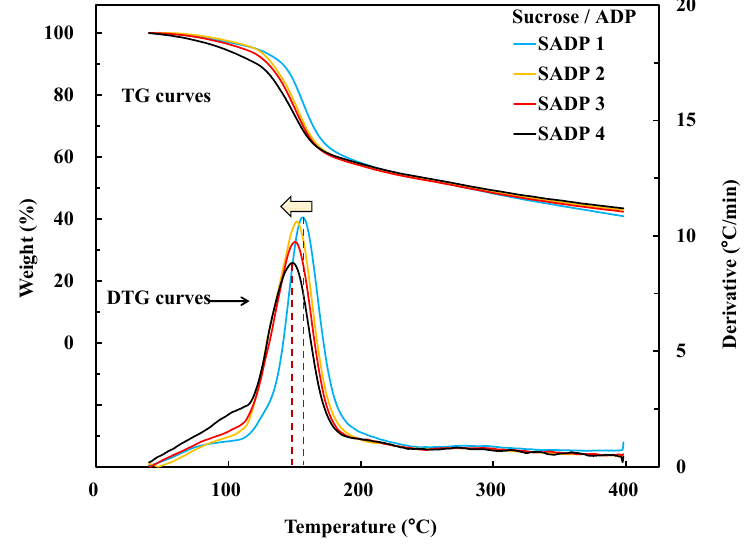
Figure 5. TG and DTG curves of each SADP adhesive.